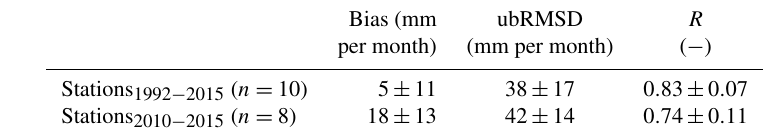
Table 3. Skill metrics for monthly MERRA-2 relative to in situ precipitation: spatial average ± spatial standard deviation.